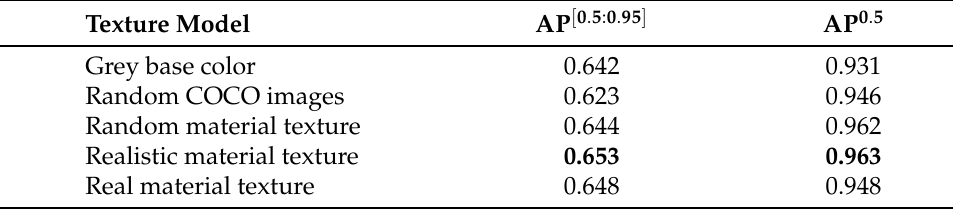
Table 5. Object texture results.